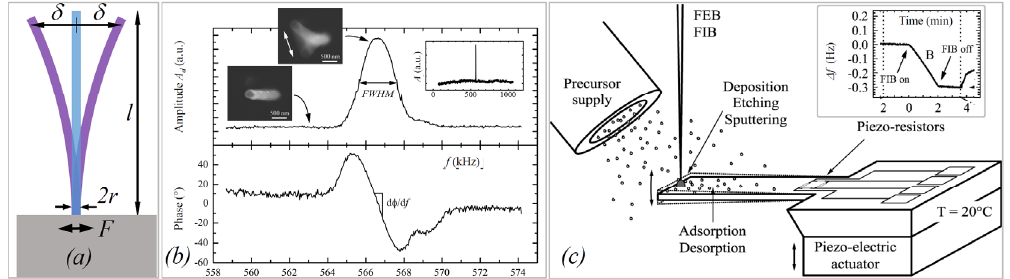
Figure 8. Density determination of FEBID/FIBID nanostructures. ( a ) Resonant vibration mode of single clamped pillars. The alternating excitation force can be applied via the pillar substrate through piezoactuators or via electrostatic forces surrounding the pillar. ( b ) Frequency sweeps of vibration amplitude (upper) and phase shift (lower) for a FEBID pillar across its fundamental vibration. The frequency inset shows the total 1 MHz scan and a single excitation, which is due to the uniformity of the deposited pillar. The SEM observation insets show the top view of the pillar in static and resonant mode. Modified from Friedli et al. [53]. ( c ) Mass measurement in the femtogram region via the frequency change of cantilevers during FEB or FIB deposition. The inset shows the shift in frequency during an FEBID deposition. Modified from Friedli et al. [46].